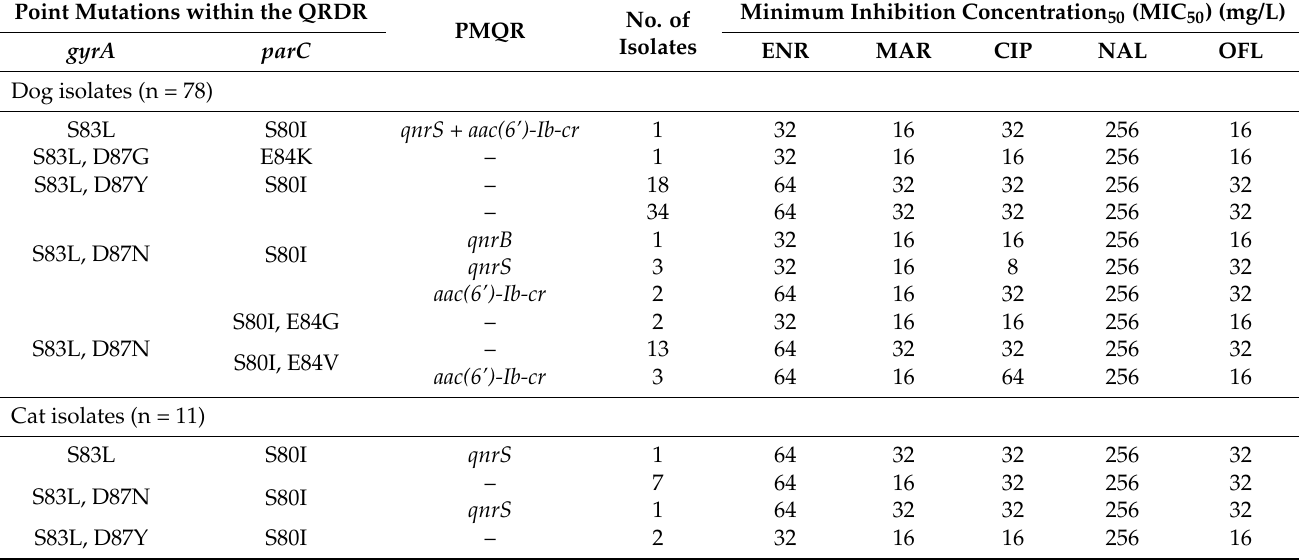
Table 4. Mechanisms of quinolone resistance of E. coli isolates from dogs and cats.